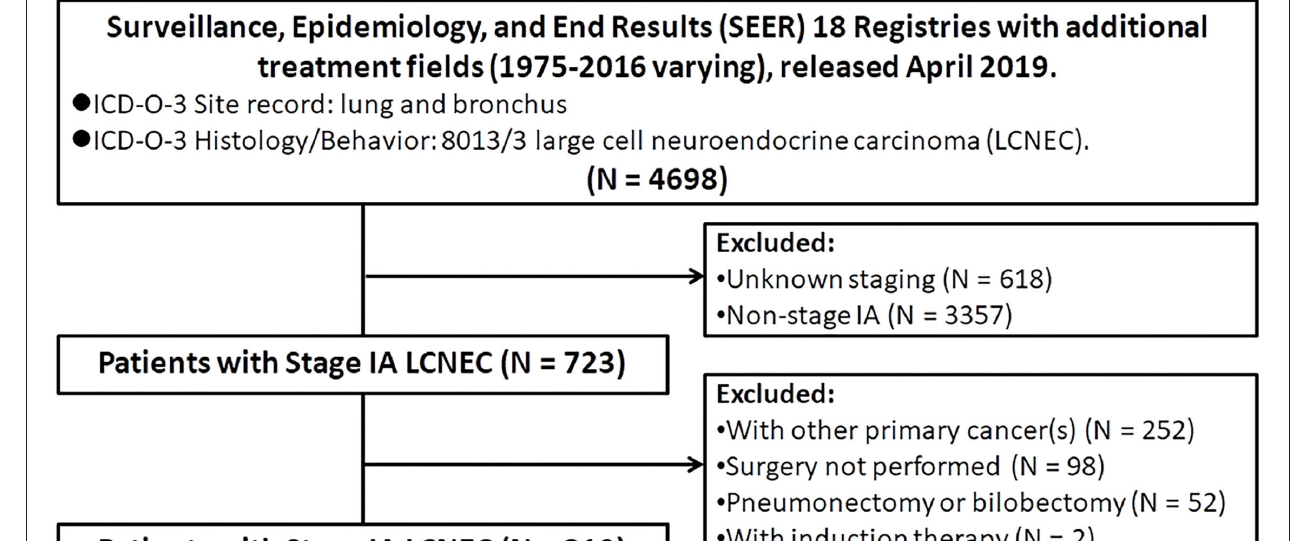
were restaged to IA1, IA2, and IA3 on basis of the American Joint Committee on Cancer 8th Tumor-Nodes-Metastasis (TNM) staging manual for lung